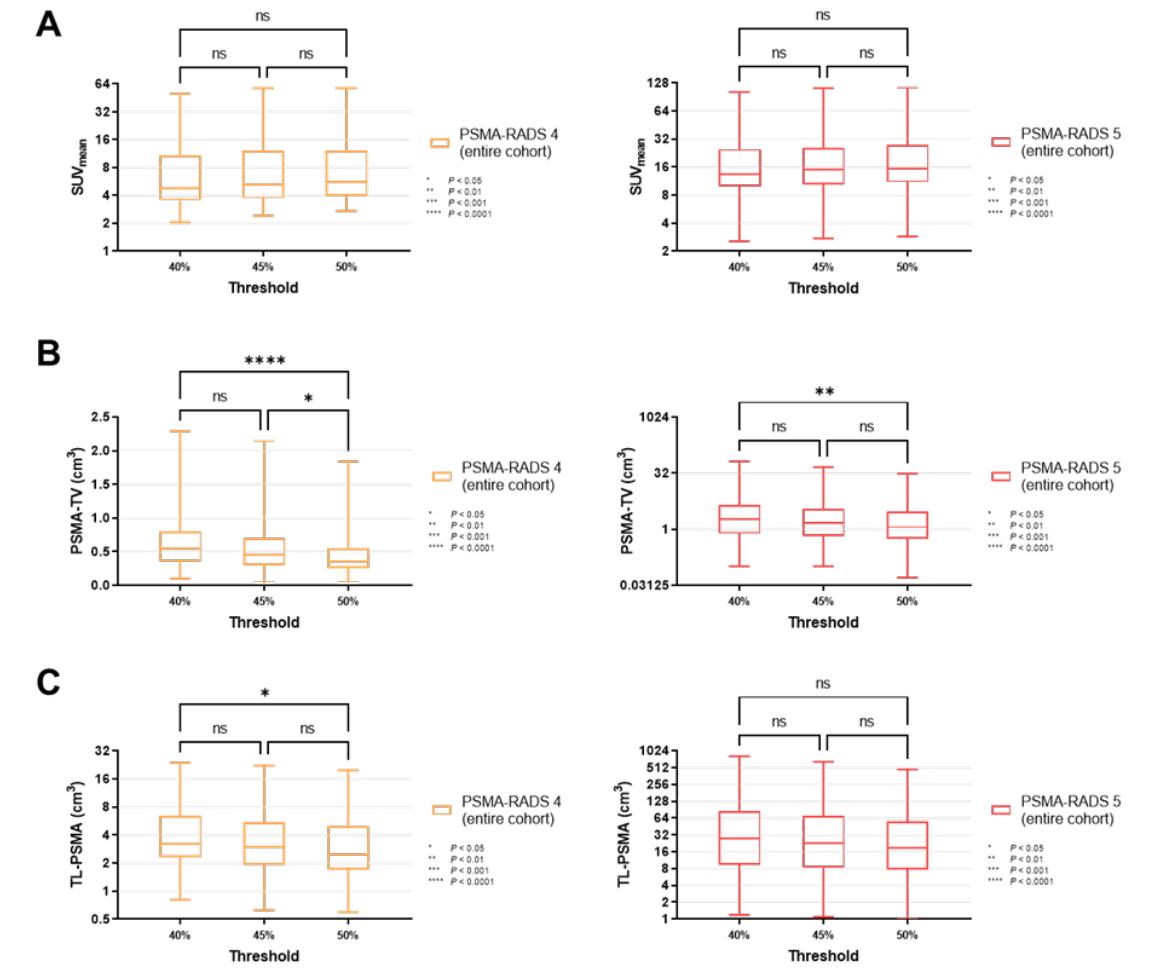
Figure 3. Box-and-whisker charts showing the mean standardized uptake values (SUV mean , ( A )) and volumetric parameters [PSMA-avid tumor volume (PSMA-TV, ( B )), and total lesion (TL-PSMA, ( C ))], depending on the chosen intensity threshold (40 vs. 45 vs. 50%), for all lesions classified as PSMA-RADS-4 or -5 (overall lesion level). ( A ) SUV mean did not differ significantly between different intensity thresholds, for both PSMA-RADS-4 ( p ≥ 0.34) and -5 lesions ( p ≥ 0.30). ( B ) PSMA-TV changed significantly when changing the intensity threshold from 40 to 50% (PSMA-RADS-4, p < 0.0001; PSMA-RADS-5, p = 0.0066). When changing the intensity threshold in a smaller increment to 45%, the differences became largely insignificant (except for PSMA-RADS-4, p = 0.0450) ( C ) While changing the intensity threshold from 40 to 50% led to a significant difference in TL-PSMA of PSMA-RADS-4 lesions ( p = 0.0272), TL-PSMA did not change significantly when smaller increments of 5% were applied ( p ≥ 0.54). For PSMA-RADS-5 lesions, there was no statistical difference between the individual subgroups ( p ≥ 0.16). Data are shown on a logarithmic scale (exception: linear scale for PSMA-TV in the PSMA-RADS-4 cohort). PSMA-RADS = prostate-specific membrane antigen reporting and data system.